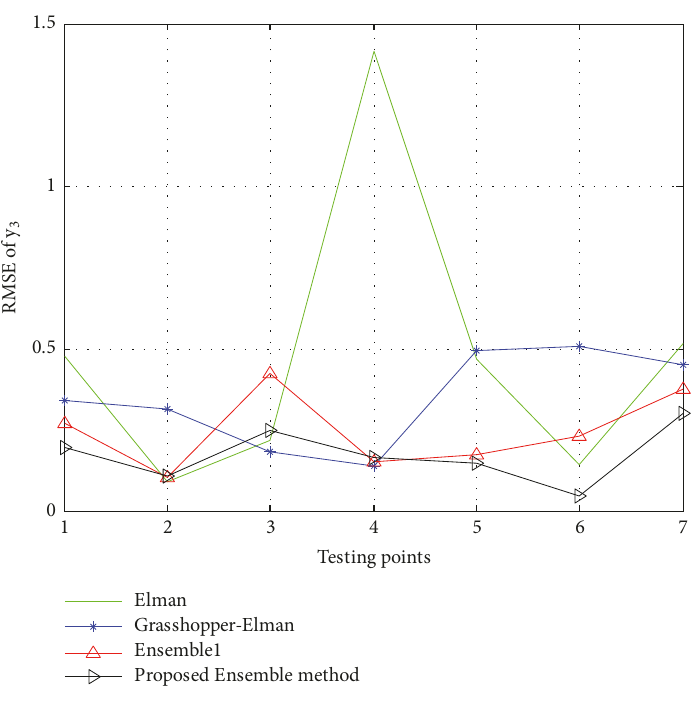
Figure 9: Prediction RMSE of y 3 .